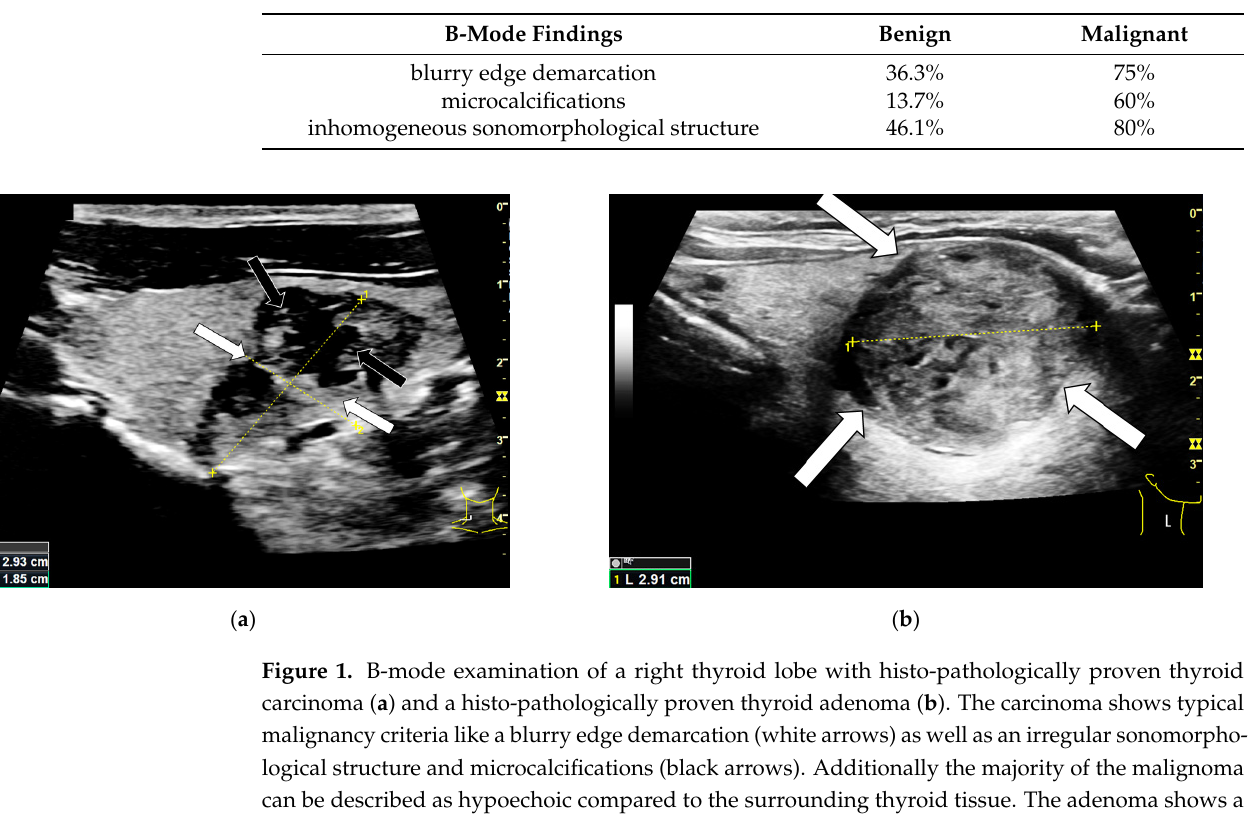
Table 2. Frequency of malignant B-mode findings in benign and malignant thyroid nodules.